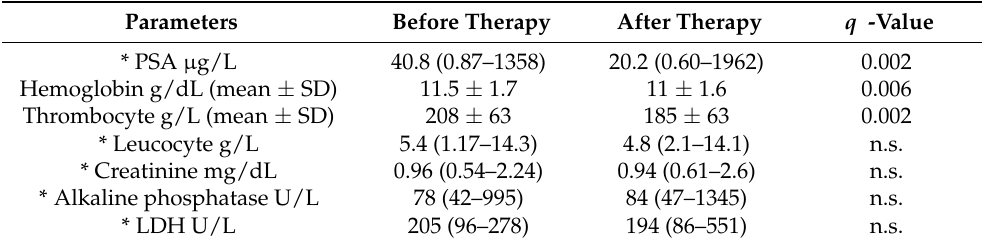
Table 2. Comparison of laboratory parameters of the studied mCRPC patients before and after the second course of three cycles of PSMA-RLT every 4 weeks.